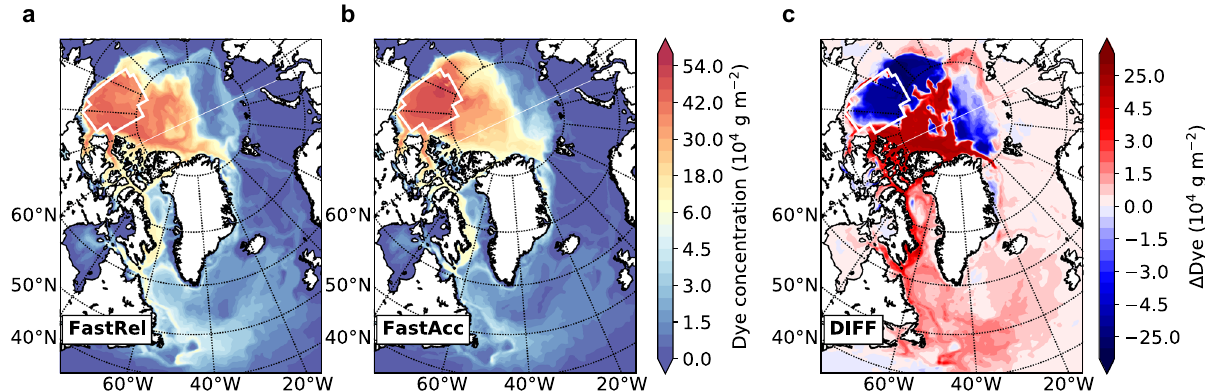
Fig. 2 Fate of the Beaufort Gyre (BG) freshwater in different scenarios. Distribution of vertically integrated dye tracer concentration by the end of each 13-year simulations of FastRel (1983 – 1995 with rapid release of freshwater from the BG; a ), FastAcc (1996 – 2008 with rapid freshwater accumulation in the BG; b ), and the difference (FastRel minus FastAcc) between them ( c ). White boxes indicate the BG region where tracers